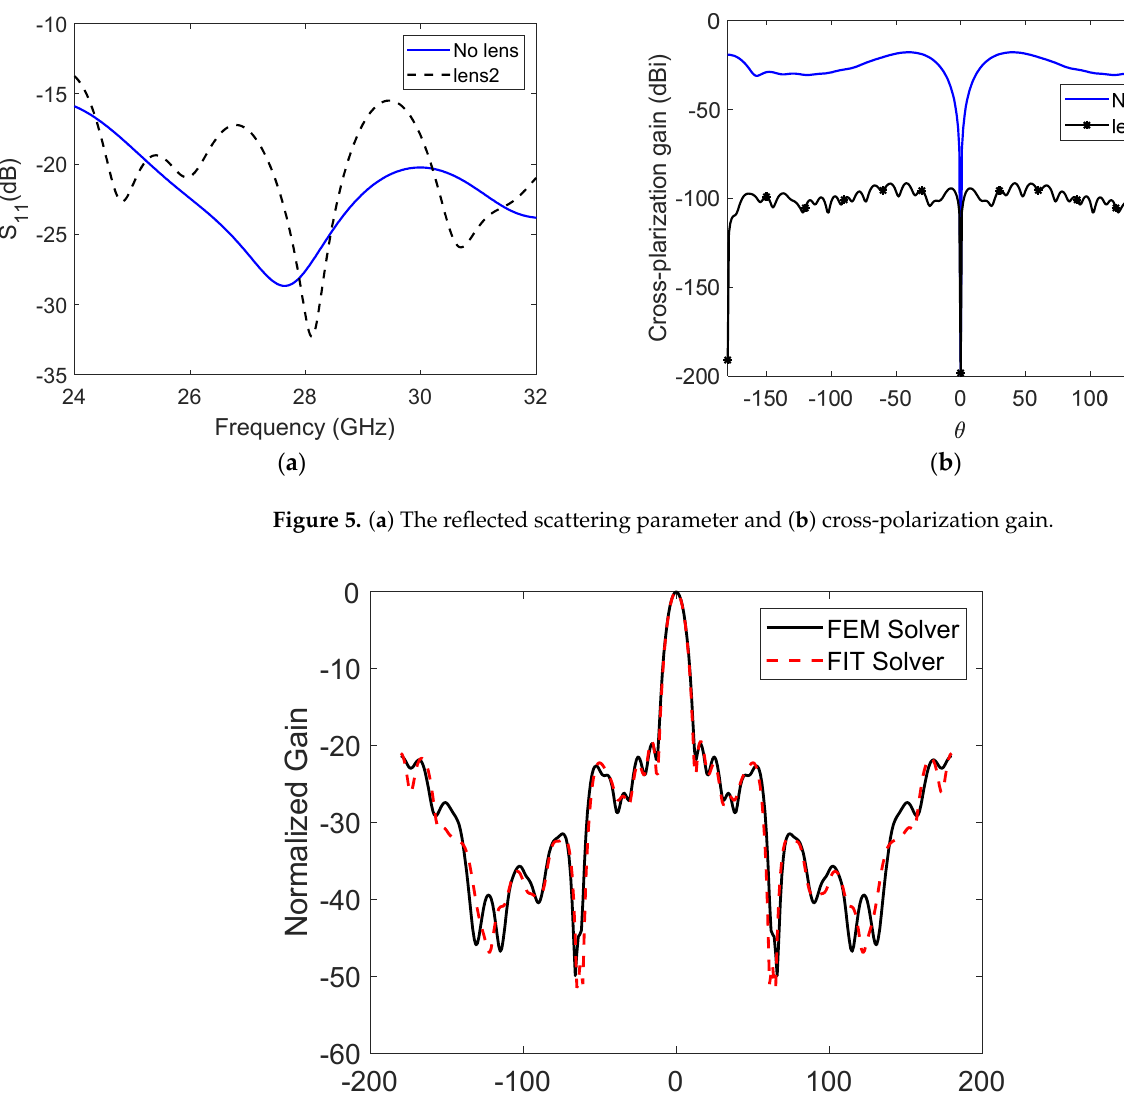
Figure 6. The normalized co ‐ polarized radiation pattern of the horn antenna with a dielectric slabs ‐ based lens using different full ‐ wave simulators. The aperture area of the designed lens is a = 64.52 mm, and the horn antenna is placed at the optimized focal point ( 𝑓 = 50.62 mm).